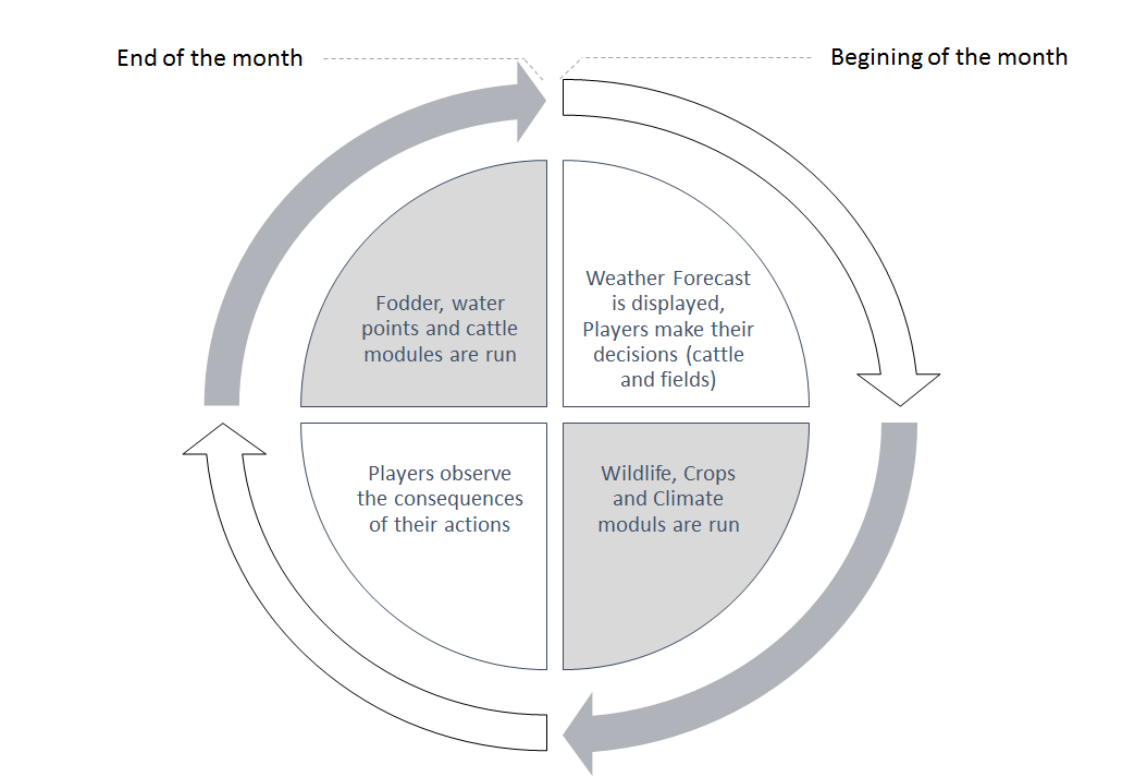
Figure 3. Sequential mobilization of the modules during the playing session. A round of playing, that is a month in the model, is done in four steps. Grey phases represent moments were the model is run, white phases are moments when the model is paused. The model is constituted of different modules, controlling specific dynamics (see next paragraphs). These modules are mobilized at specific steps of the month, as showed by the